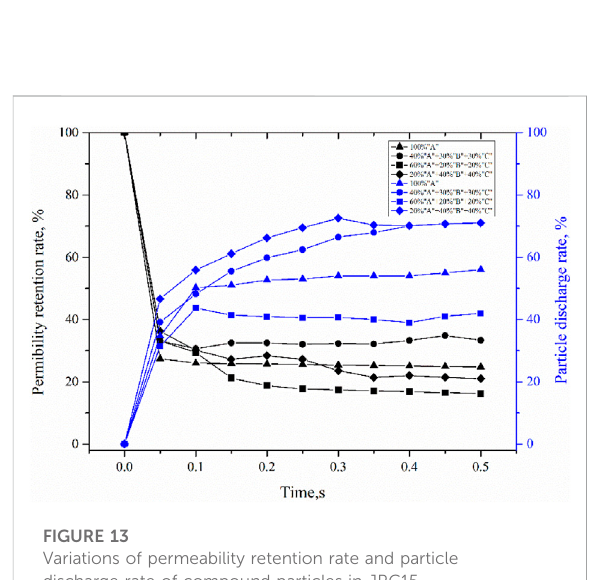
FIGURE 13 Variations of permeability retention rate and particle discharge rate of compound particles in